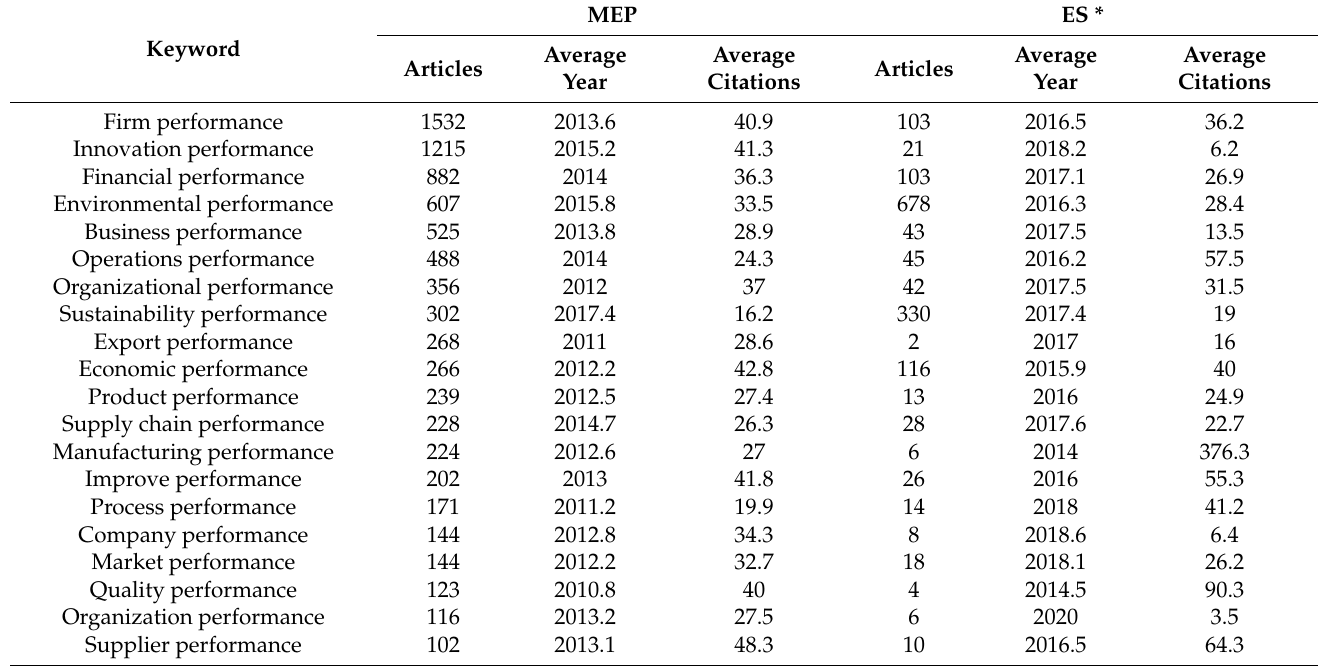
Table 3. Instances of “performance” keywords in the MEP and ES